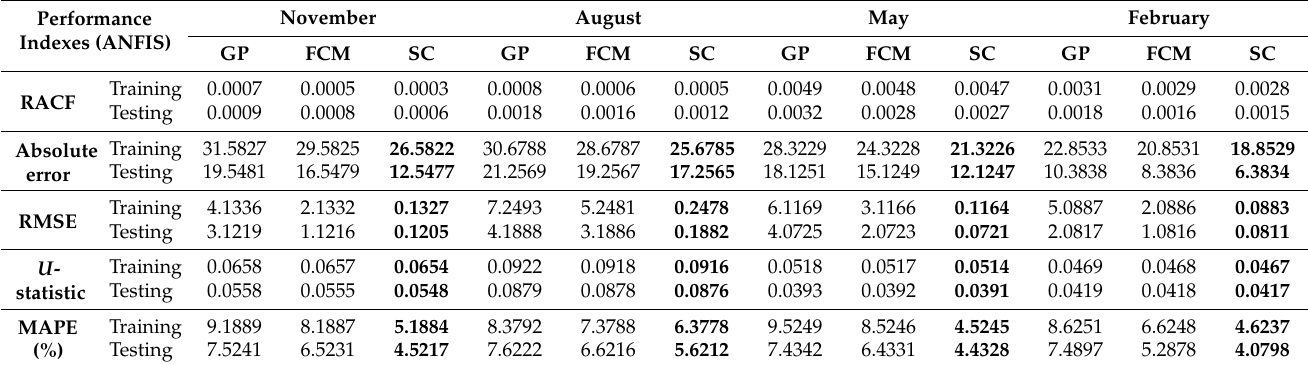
Table 3. Comparison of different ANFIS models for different